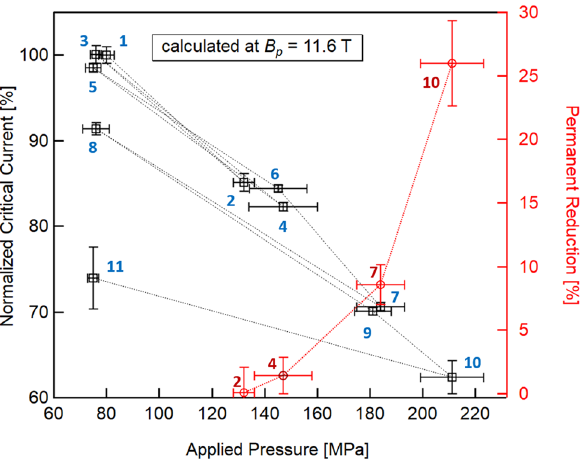
Figure 4. Percentage of reversible (black squares) and permanent reduction (red diamonds) of the critical current with a transversal pressure applied along the cables for a peak field of 11.6 T. The results from the first test (the baseline performed at 80 MPa) is used as reference for the